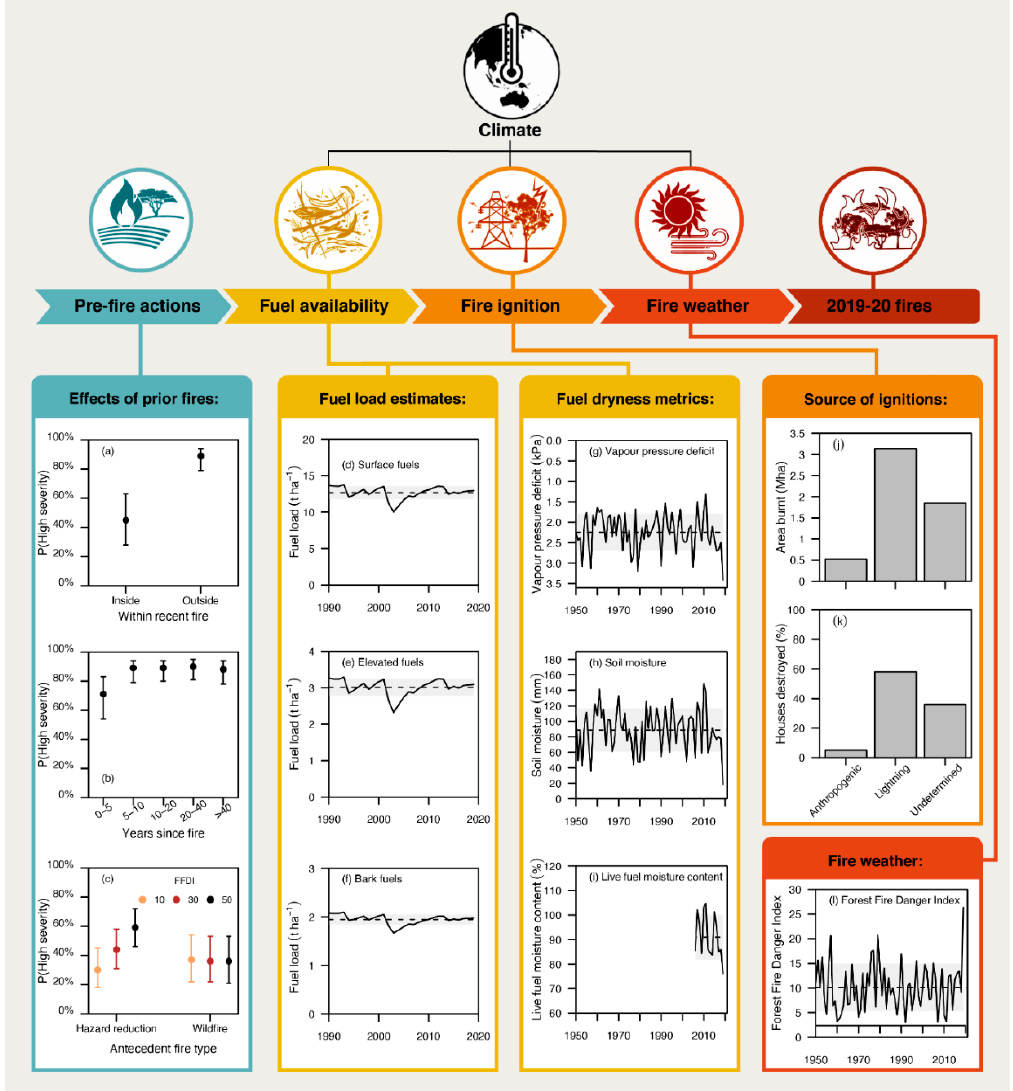
Figure 2. Overview of the causes of the extent and severity of the Black Summer fires. The effects of historical fires on the probability of high-severity fire (P(High severity)) are illustrated as a function of: ( a ) past fire presence (either inside or outside recent antecedent fire); ( b ) time since fire; and ( c ) past fire type (either hazard reduction burns or wildfire), in combination with fire weather (Forest Fire Danger Index; FFDI). Historical estimates of fuel loads ( d – f ), fuel dryness metrics ( g – i ) and Forest Fire Danger Index ( l ) are shown for the Sydney Basin bioregion (Figure S1). These figures show mean monthly values, dashed lines represent averages and shading represents ±1 SD of average values. Other bioregions display similar trends, as shown in Figures S2–S4. Note, the y-axes for figures ( d – i ) and ( l ) are scaled such that the y-axis range is the same for each bioregion examined (Figures S2–S4). Live fuel moisture content was estimated from MODIS satellite data available from 2000. Sources of fire ignition for the NSW fires are illustrated as a function of area burnt ( j ) and houses destroyed ( k ).